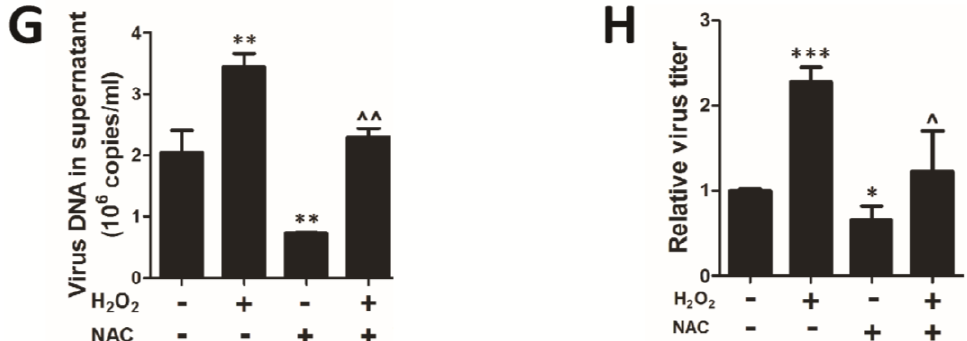
Figure 4. H O scavengers inhibit H O -induced HCMV lytic replication in vitro . 2 2 2 2 Figure 4. H 2 O 2 scavengers inhibit H 2 O 2 -induced HCMV lytic replication in vitro . Treatment with the H O scavenger N -acetylcysteine (NAC) (5 mM) was shown to decrease 2 2 Treatment with the H 2 O 2 scavenger N -acetylcysteine (NAC) (5 mM) was shown to ROS production in HFF cells by measurement of fluorescence ( A ). Cells were treated with decrease ROS production in HFF cells by measurement of fluorescence ( A ). Cells were 200 µ M H O without any scavengers, or with the scavenger NAC at 5 mM, catalase at 2 2 treated with 200 μM H 2 O 2 without any scavengers, or with the scavenger NAC at 5 mM, 800 U/mL or reduced glutathione at 5 mM for 24 h and then HCMV infection (MOI = 0.5). catalase at 800 U/mL or reduced glutathione at 5 mM for 24 h and then HCMV infection H O scavengers reduced H O (200 µ M) and ATA (4 mM)-induction of MIE promoter 2 2 2 2 (MOI = 0.5). H 2 O 2 scavengers reduced H 2 O 2 (200 μM) and ATA (4 mM)-induction of activity and IE transcription in HFF cells ( B , C ). Treated with 200 µ M H O upregulated 2 2 MIE promoter activity and IE transcription in HFF cells ( B , C ). Treated with 200 μM H 2 O 2 HCMV lytic replication, but inhibited by treatment with 5 mM NAC. pp72 and pp65 viral upregulated HCMV lytic replication, but inhibited by treatment with 5 mM NAC. pp72 and proteins in UV-HCMV (UV) or HCMV infected HFF cells treated with NAC (5 mM) for pp65 viral proteins in UV-HCMV (UV) or HCMV infected HFF cells treated with NAC (5 72 h were determined by Western blotting with β -actin to calibrate sample loading ( E , F ). mM) for 72 h were determined by Western blotting with β-actin to calibrate sample Treatment with 5 mM NAC downregulated viral DNA load ( G ) in culture supernatants and loading ( E , F ). Treatment with 5 mM NAC downregulated viral DNA load ( G ) in culture viral titer ( H ) in the presence or absence of 200 µ M H O . * p < 0.05; ** p < 0.01 or 2 2 supernatants and viral titer ( H ) in the presence or absence of 200 μM H 2 O 2 . * p < 0.05; *** p < 0.001 for treated versus untreated cells. ˆ p < 0.05; ˆˆ p < 0.01 or ˆˆˆ p < 0.001 for ** p < 0.01 or *** p < 0.001 for treated versus untreated cells. ^ p < 0.05; ^^ p < 0.01 or H O scavenger-treated cells versus H O - or ATA-treated 2 2 2 2 ^^^ p < 0.001 for H 2 O 2 scavenger-treated cells versus H 2 O 2 - or ATA-treated cells.